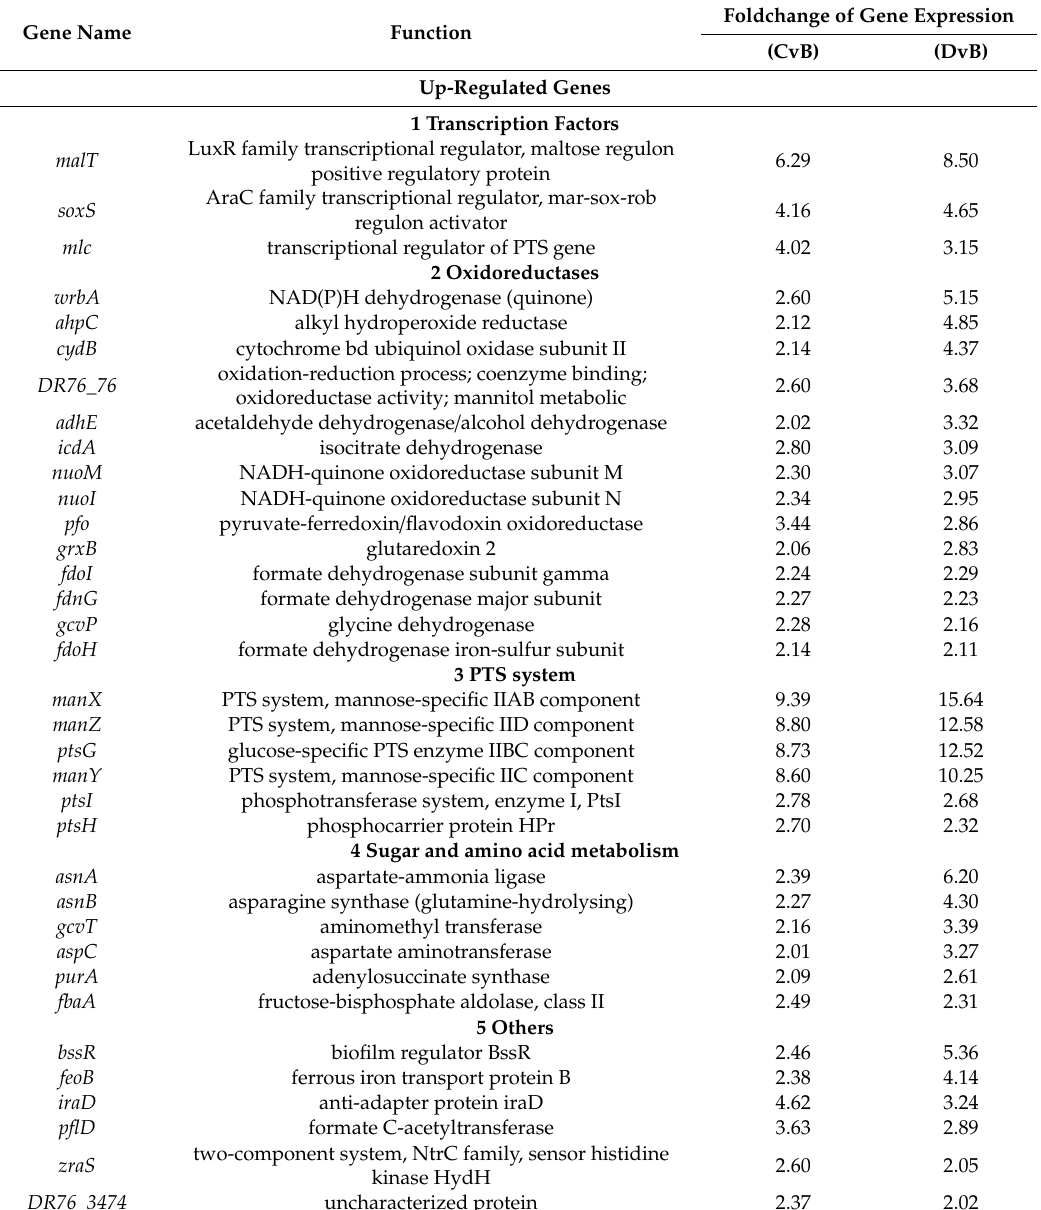
Table 1. Co-differentiallyexpressedgenesin E.coli ATCC25922 induced by1 / 2 × MICand1 / 10 ×